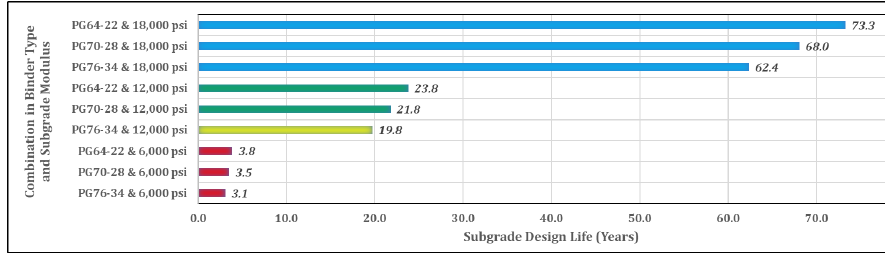
Figure 34: Influence of subgrade modulus and binder type on subgrade service life in asphaltic overlayment track.